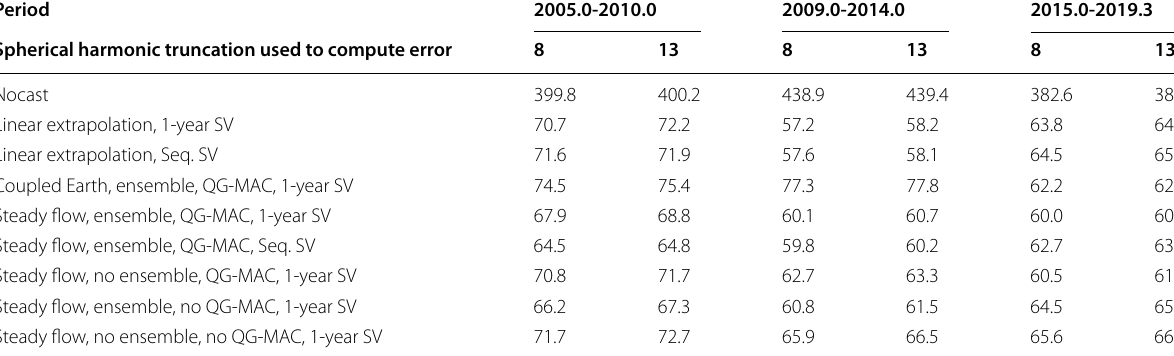
Table 1 Forecast error (in nT) over recent periods for different forecasting strategies, and using two classes of input models. The forecast error is expressed as the root-mean-squared difference between the true geomagnetic field vector, defined by an update of the CHAOS-6 field model (Finlay et al. 2016), and the forecast at the terminal epoch. The forecast error is computed for a spherical harmonic truncation equal to either 8 or 13, to conform with the IGRF framework on the one hand and to enable comparison with our previously published results on the other hand. Nocast assumes that the field does not change. Linear extrapolation assumes a linear variation whose slope is specified by the secular variation up to degree and order 8 / 13 at the start of the forecast period, as specified by the input model fed to the inverse geodynamo modelling framework: “1-year SV” means that the input model is determined based on one year of satellite data prior to the forecast; “Seq. SV” implies that the full set of satellite data available before the beginning of the forecast is used to compute the input model, using a sequential Kalman filter with analysis steps every 12 months. “Coupled Earth, ensemble, QG-MAC” indicates that the full coupled Earth dynamo model is integrated for an ensemble comprising 100 members, with the median defining the forecast, and an initialization where the QG-MAC constraint is mildly enforced for the flow at the core surface. In the bottom five rows, “steady flow” implies that the sole three-dimensional induction equation (with magnetic diffusion) is integrated, with or without an ensemble approach, and with or without the mild imposition of the QG-MAC constraint. If an ensemble approach is adopted, it is the median that defines the forecast. All non-“Seq. SV” entries for SH truncation at degree 13 taken from Fournier et al. (2021, Tab.